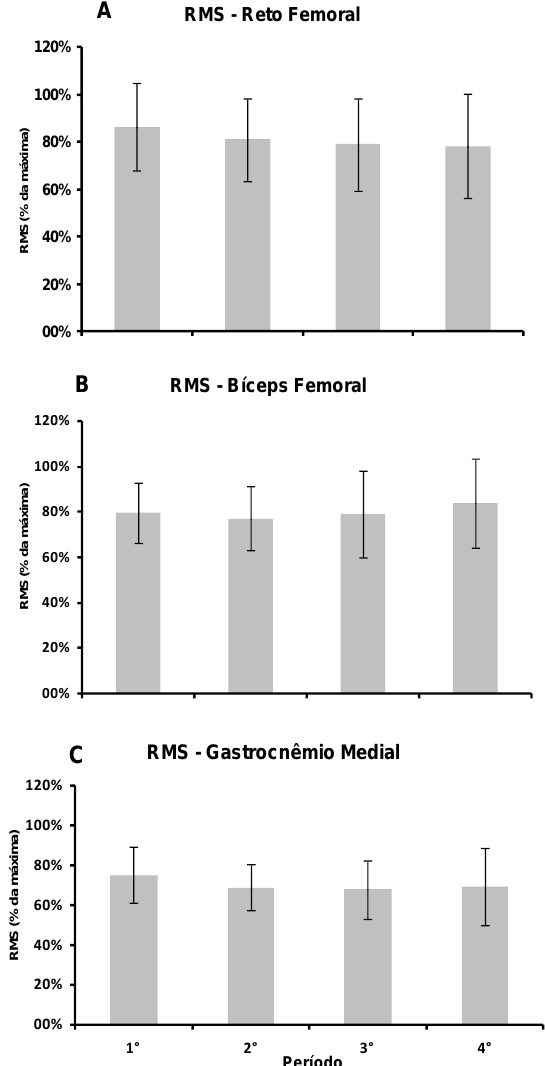
Figura 3- Valores em RMS normalizados dos músculos avaliados durante o protocolo de resistência de saltos verticais: A ) Reto Femoral; B ) Bíceps Femoral; C ) Gastrocnêmio